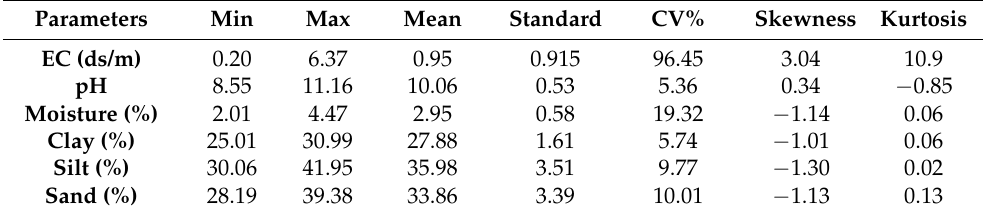
Table 2. Statistical description of soil properties of the soil samples.